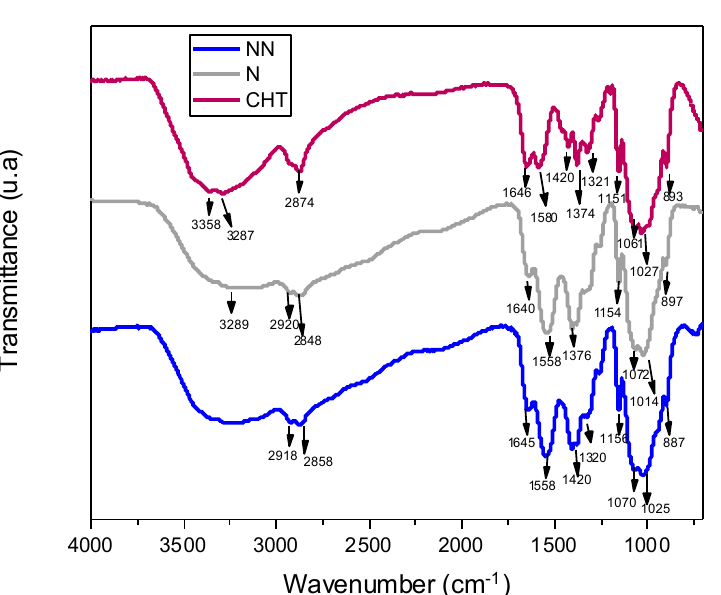
Figure 2. FTIR spectra of pristine CHT, neutralized AH-crosslinked CHT (N), and non-neutralized AH-crosslinked CHT (NN).